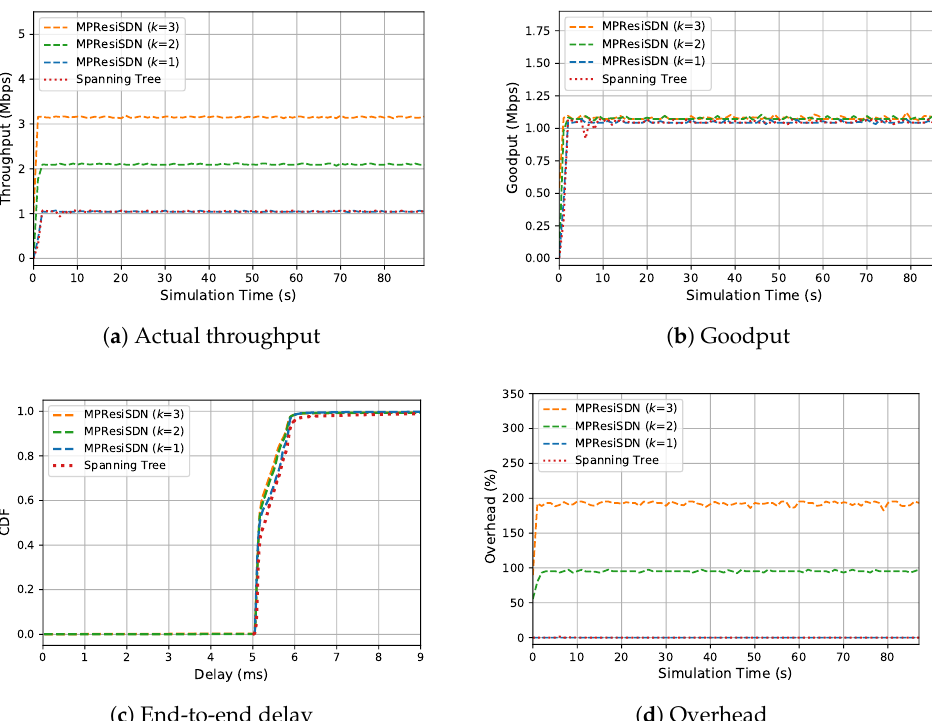
Figure 12. Comparison of the four strategies under normal